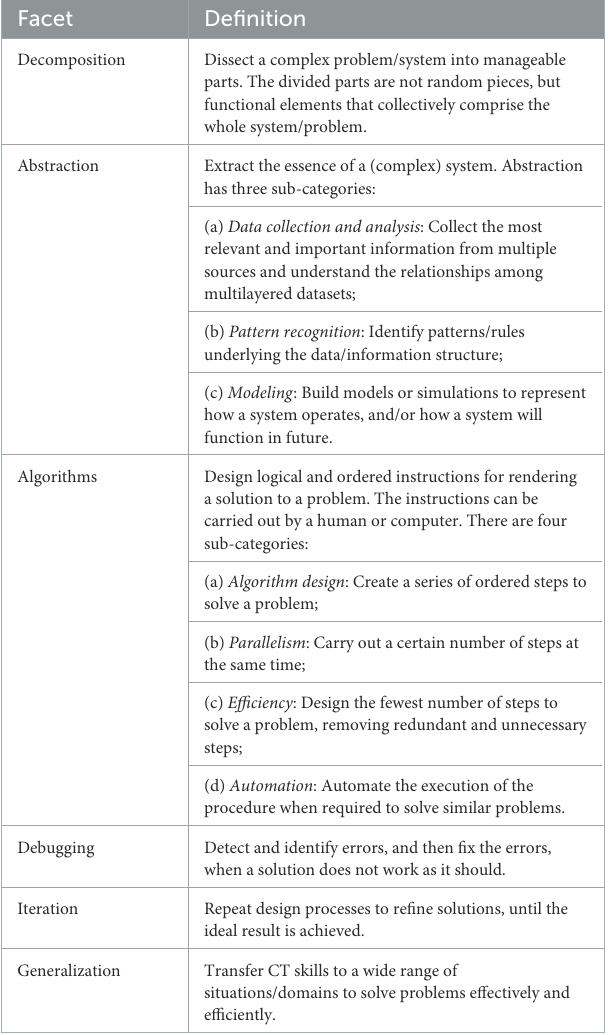
TABLE 1 Summary of CT framework (Shute et al.,